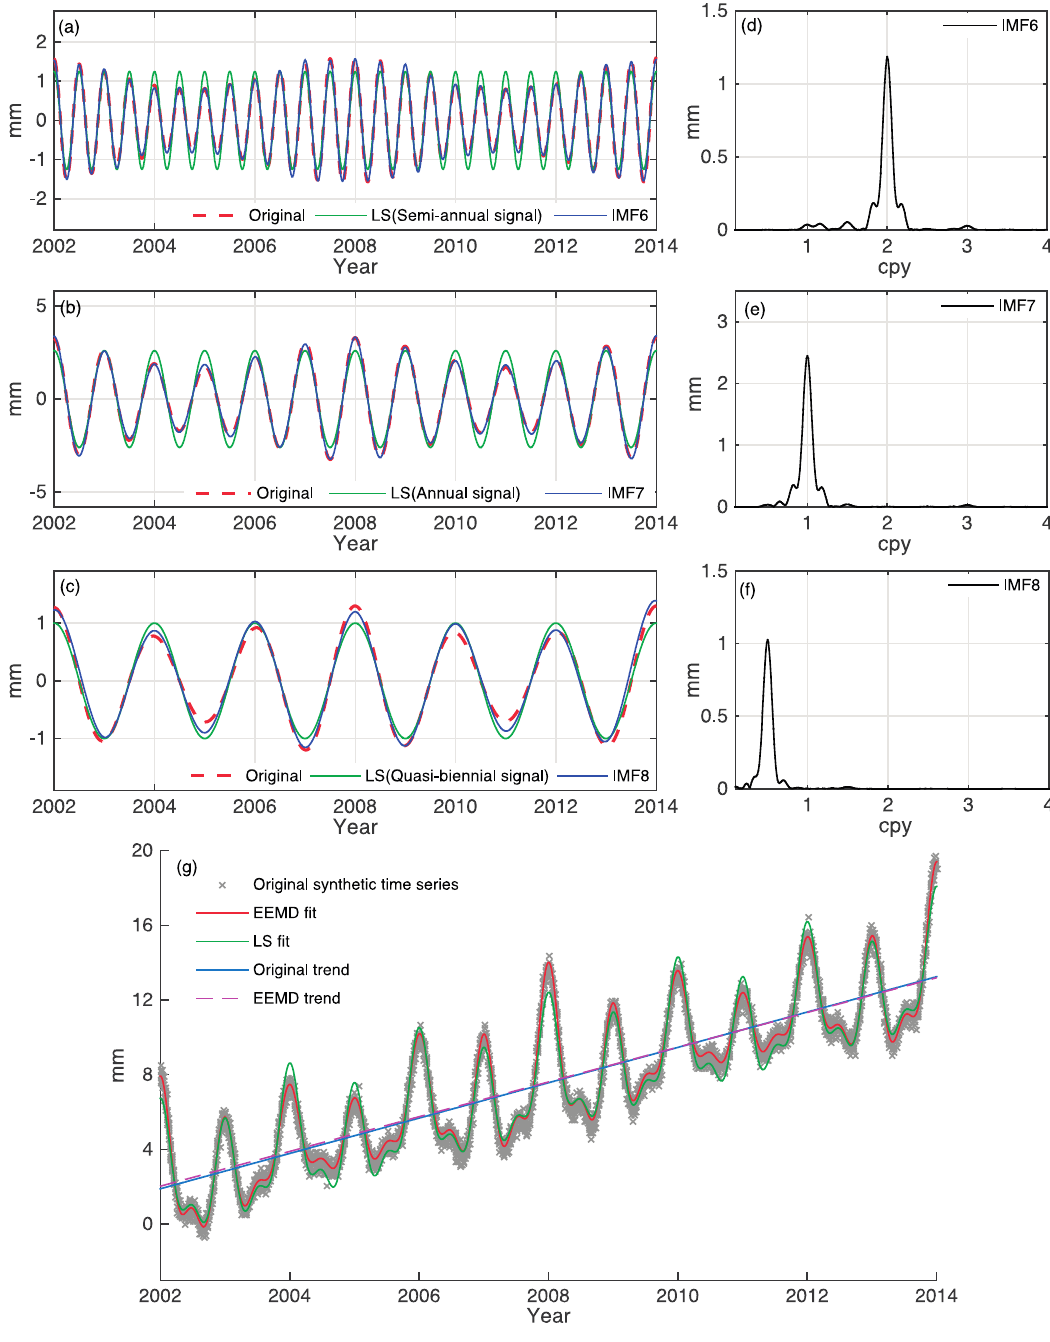
Figure 2. Comparison between synthetic time series (Equation (1)) and the decomposed IMFs. ( a ) the synthetic time series f (dotted red curve), semi-annual signal by least-squares (LS) 1 (green curve) and IMF6 (blue curve); ( b ) the synthetic time series f (red dotted curve), 2 annual signal by LS (green curve) and IMF7 (blue curve); ( c ) the synthetic time series f (red 3 dotted curve), quasi-biennial signal by LS (green curve) and IMF8 (blue curve); ( d – f ) are the amplitude spectra of IMF6–8, corresponding to the semi-annual, annual and quasi-biennial signals; ( g ) the original time series with a trend (gray dots), the sum of IMF6, IMF7 and IMF8 with the trend (red curve) and the LS fit (green curve), the original trend (blue curve) and EEMD decomposed trend (dotted purple